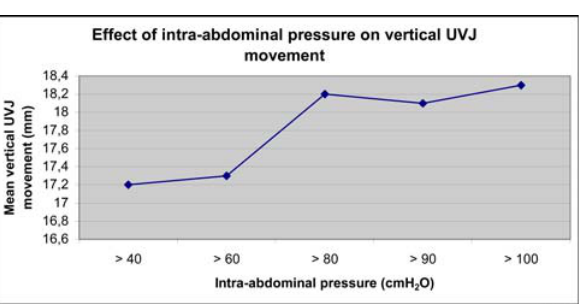
FIGURE 1 - The behavior of the VUVJ movement according to increased levels of IAP on perineal ultrasound assessments with a barely empty bladder.